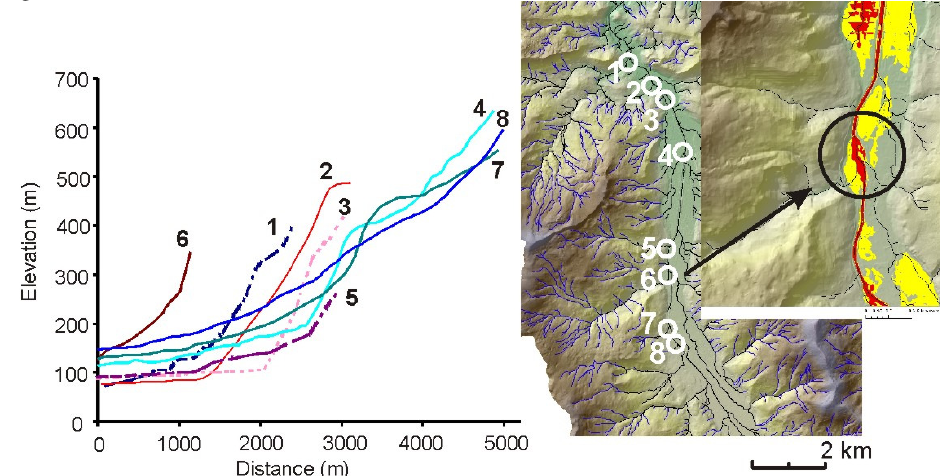
Fig. 6. Elevation (energy) gradients are shown for a select number of tributaries entering the West Fork in the wide valley (location E in Fig. 4). Tributaries 1 and 6 directly enter the mainstem and have high-energy gradients. Tributaries 2, 3, and 5 flow across the low gradient valley floor and have lower energy gradients where they intersect the West Fork. Tributaries 4, 7, and 8 are intermediate. Tributary #6 is associated with a locally wider fluvial landscape, as depicted in the image.